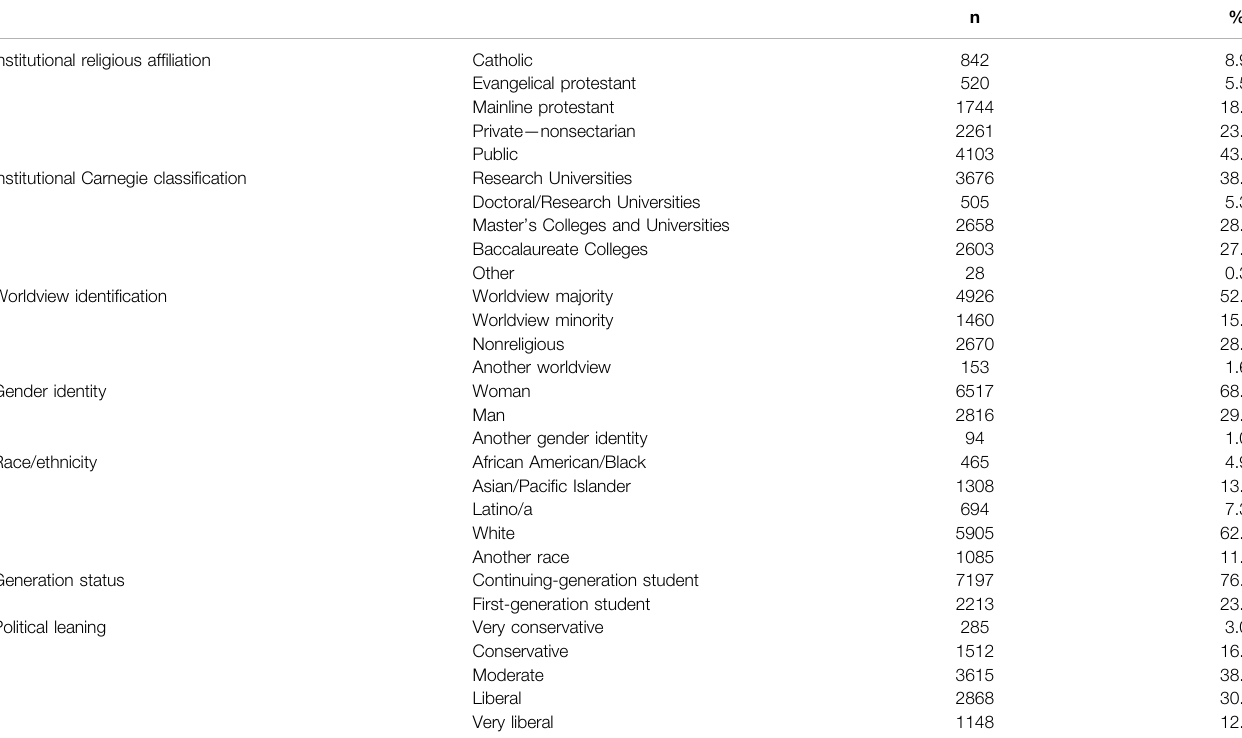
TABLE 1 | Selected analytic sample characteristics for quantitative survey ( N =